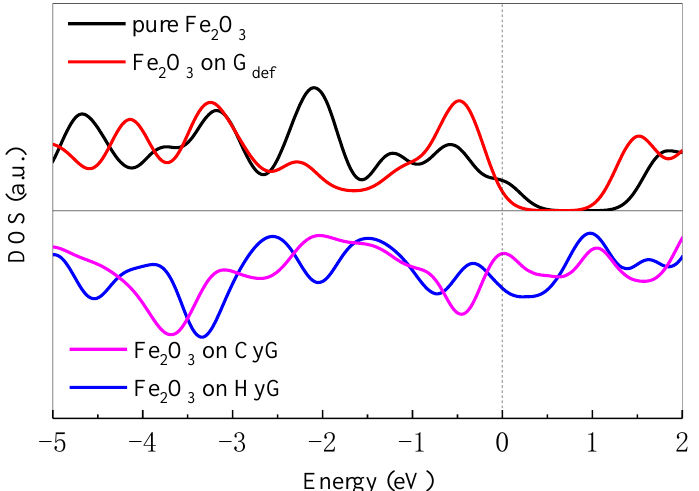
Figure 2. DOS for Fe 2 O 3 before and after supported on G def , HyG, and CyG. The vertical black dotted line indicates the Fermi level (EF = 0.000 eV).